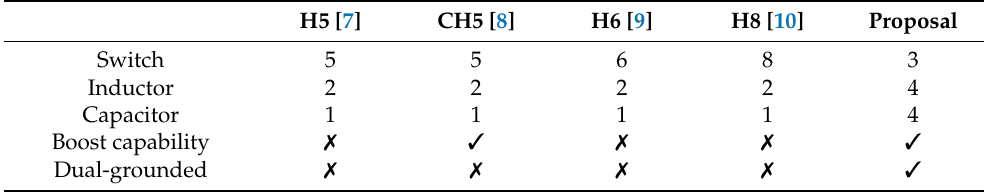
Table 2. Comparison